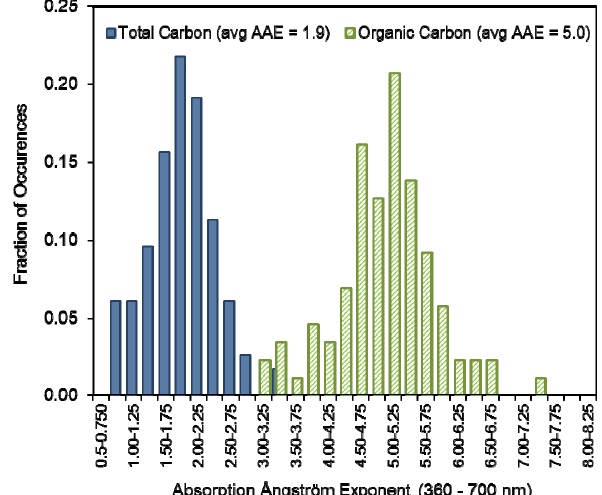
Fig. 2. Histograms of absorption ˚Angstr¨om exponents computed Fig.2. Histograms of absorption Ångströmexponents computed over the 360 to 700 nm over the 360 to 700nm spectral range: (blue bars) 115 residential spectral range: (blue bars) 115 residential wood smoke samples considered in this study wood smoke samples considered in this study and (green bars) the and (green bars) the light-absorbing organic carbon portion in 87 of the wood smoke light-absorbing organic carbon portion in 87 of the wood smoke samples.